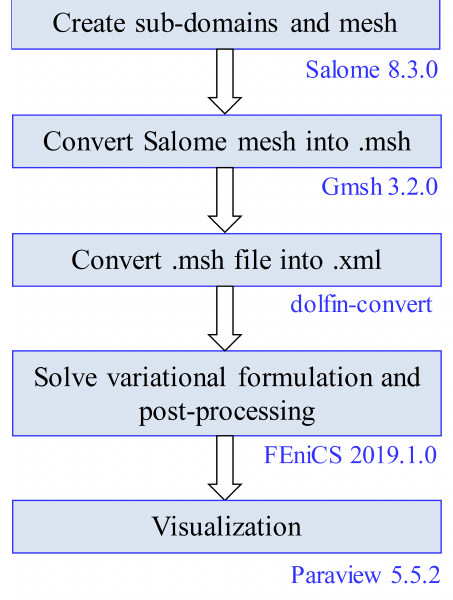
Figure 3. Proposed open-source simulation